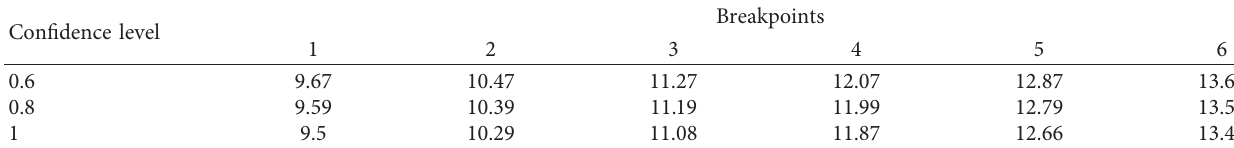
Table 6: Breakpoint values for the first sample